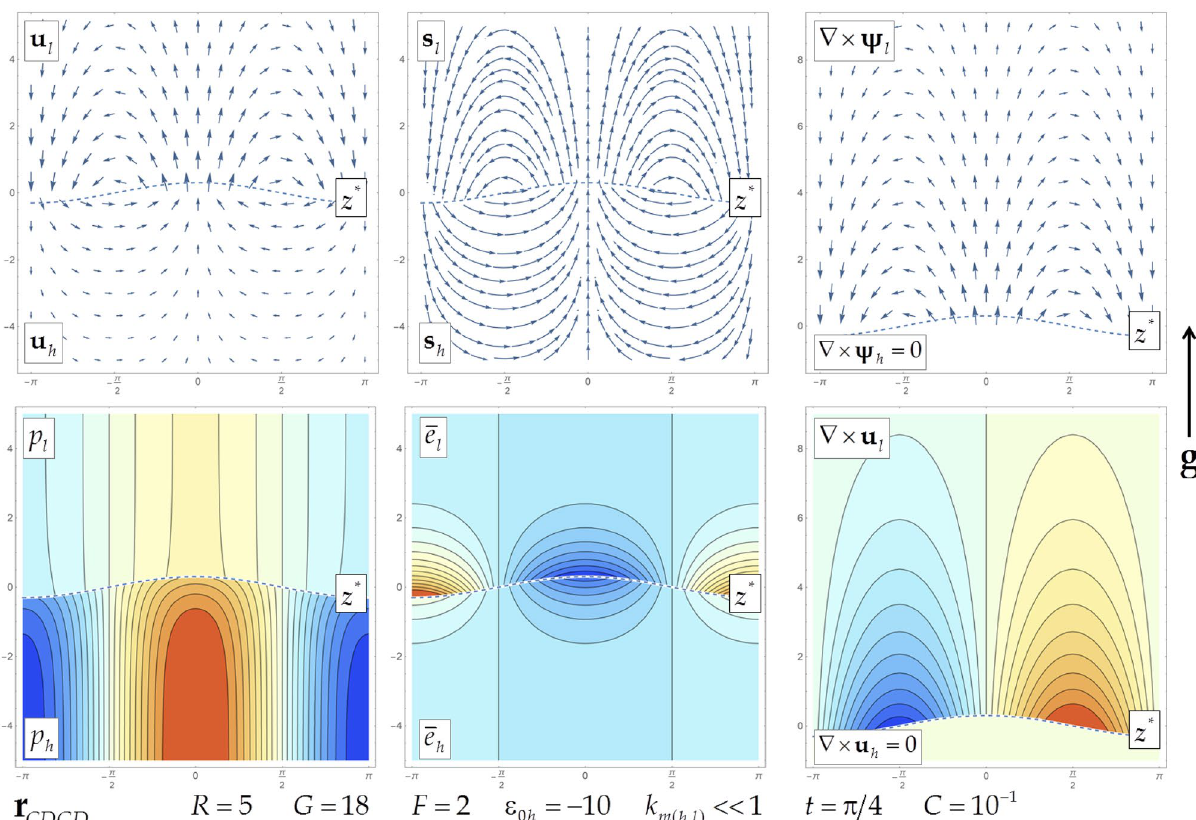
Fig. 3 Flow fields for unstable accelerated diffusion: plots of real parts of perturbed fields of the interface, velocity, velocity streamlines, pressure, vorticity, internal energy, with red (blue) for positive (negative) in contour